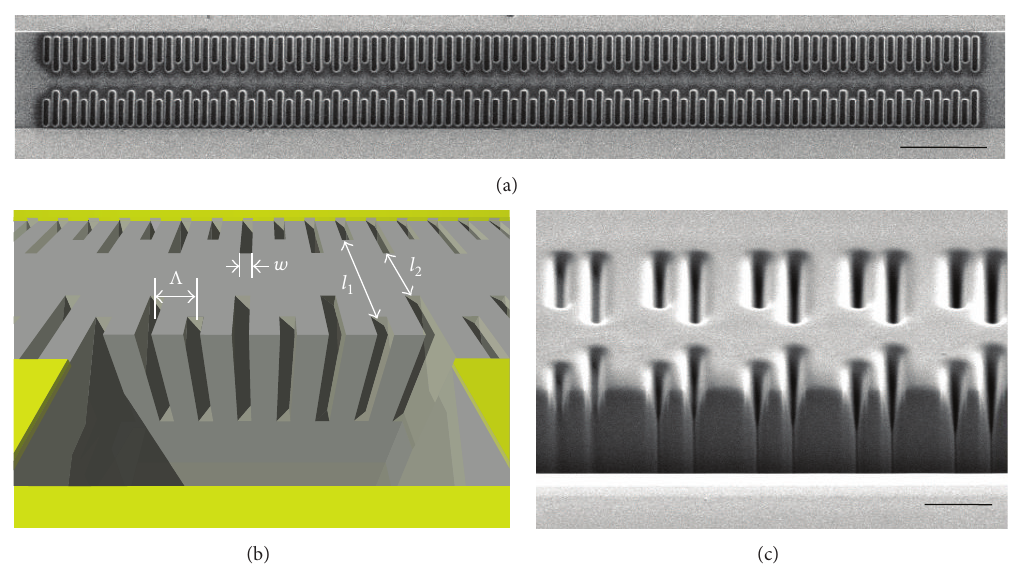
Figure 2: (a) SEM top-view image of a coupled resonator photonic crystal. Scale bar denotes 10 𝜇 m. (b) A cartoon showing the design parameters of the structure. The cross section shows the expected vertical walls. (c) Tilted SEM image of the FIB milled CR structure. The cross section shows angled side walls and limited depth of air trenches. The scale bar denotes 5 𝜇